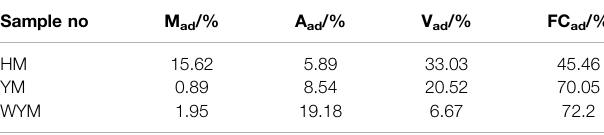
TABLE 1 | The data of industrial analysis of coal